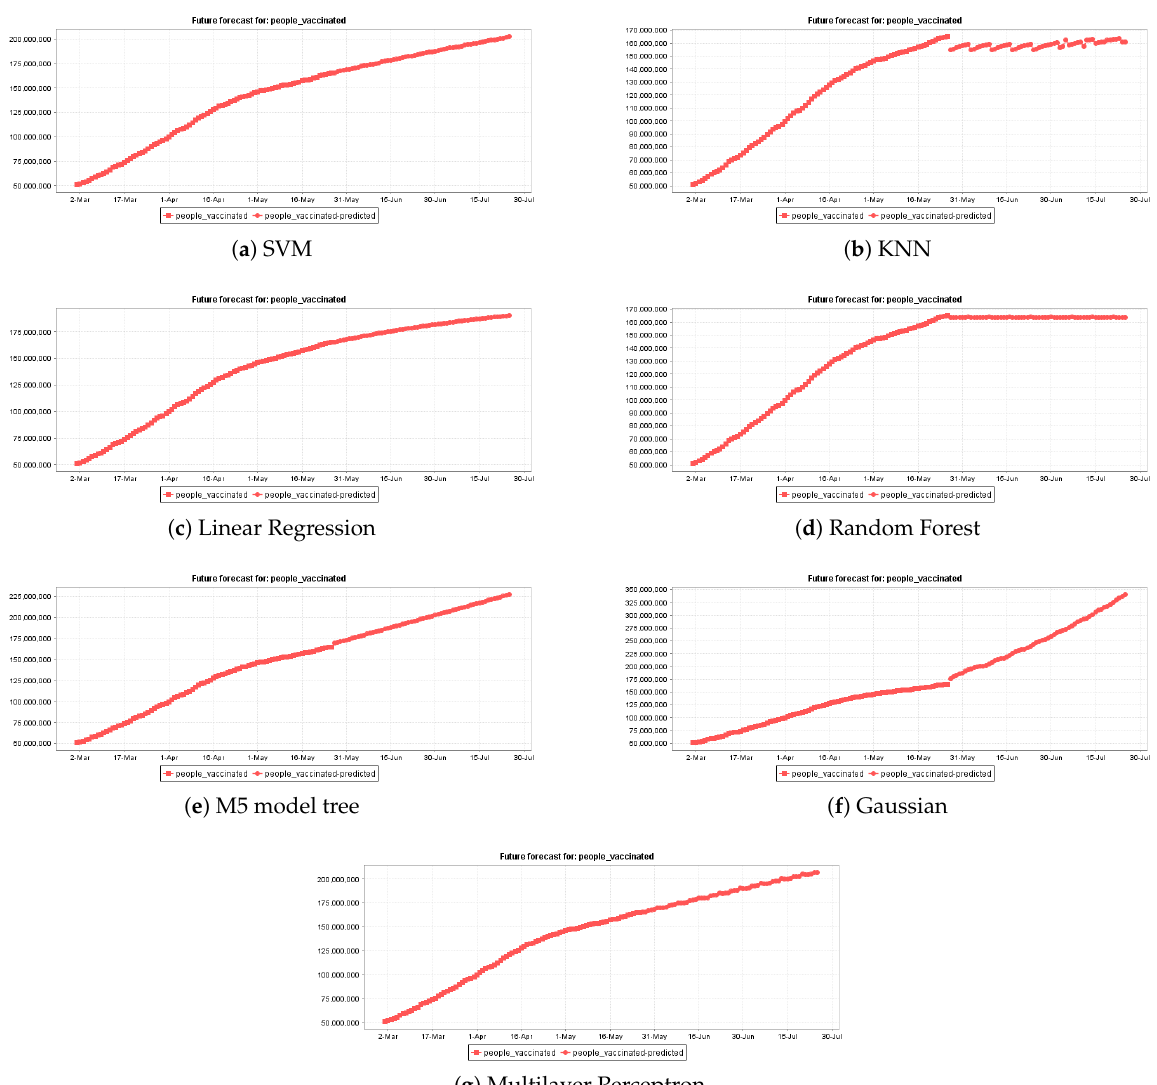
Figure 15. COVID-19 vaccination prediction to forecast partially vaccinated population in the USA for different machine learning models with forecast time of 2